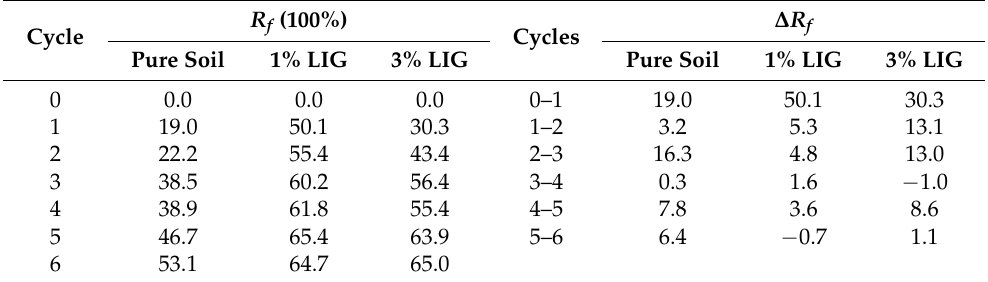
Figure 7. Changes of UCS with wetting and drying cycles. Table 3. Values of reduction factor and difference in reduction factor during each wetting/drying cycle.